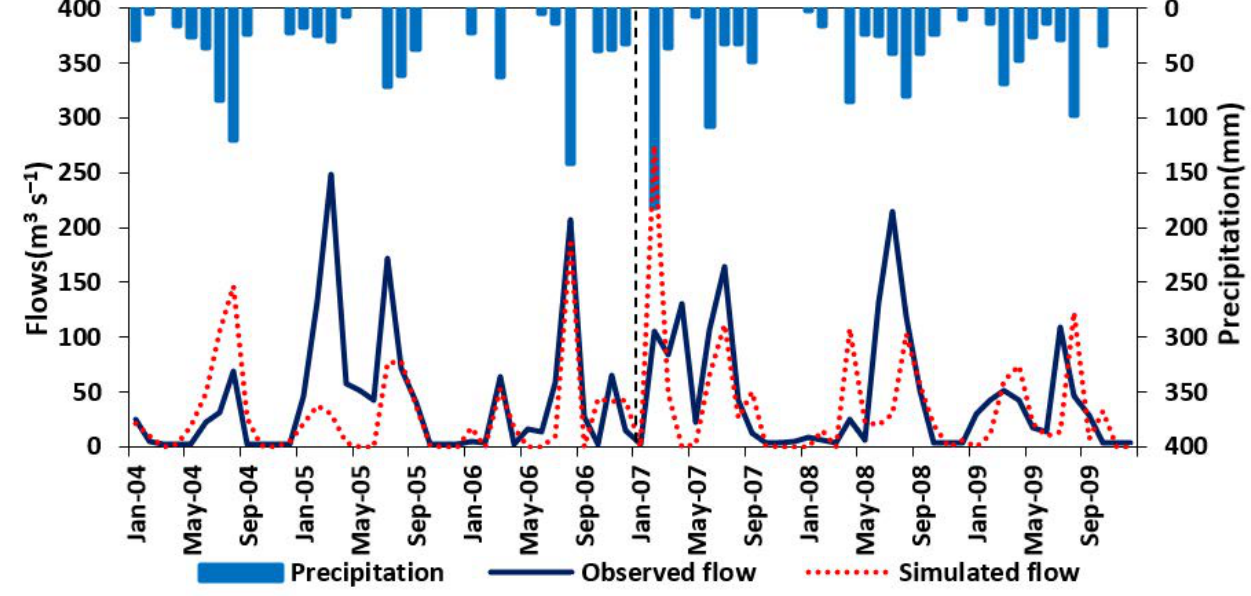
Figure 4. Simulated and observed hydrograph on monthly basis using precipitation gauge data for the calibration (2004–2006) and validation (2007–2009)